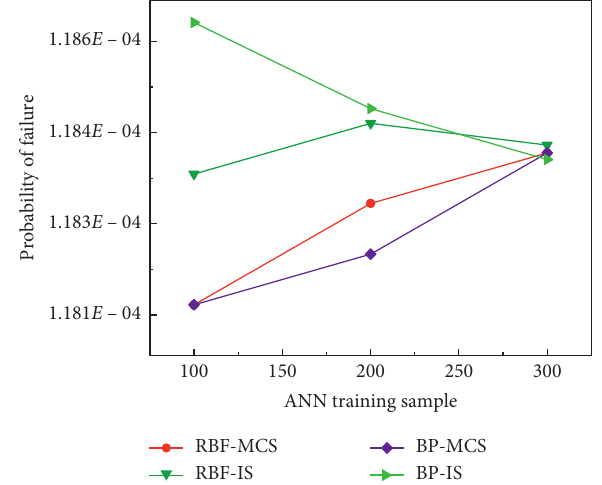
Figure 14: Comparison of the POF between ANN-IS (RBF-IS and BP-IS) and various other methods relative to ANN sample data